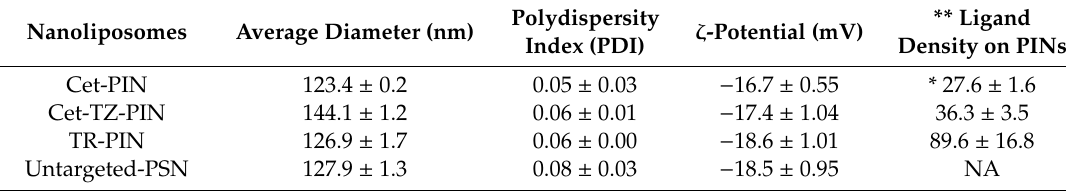
Figure 1. Schematic of the design and selective targeting of heterogeneous cancer cell subpopulations using triple-receptor-targeted photoimmuno-nanoconjugates (TR-PINs). Representation of ( a ) the design of triple-receptor-targeted PINs (TR-PINs). ( b ) Selective tumor photodestruction using Cet-targeted PINs (Cet-PINs) leading to incomplete responses, and enhanced specificity tumor photodestruction using TR-PINs leading to a more complete response within the heterogeneous tumor mass. Table1. Physicalcharacterizationofphotoimmuno-nanoconjugates(PINs)anduntargeted-photosensitizing nanoconstructs